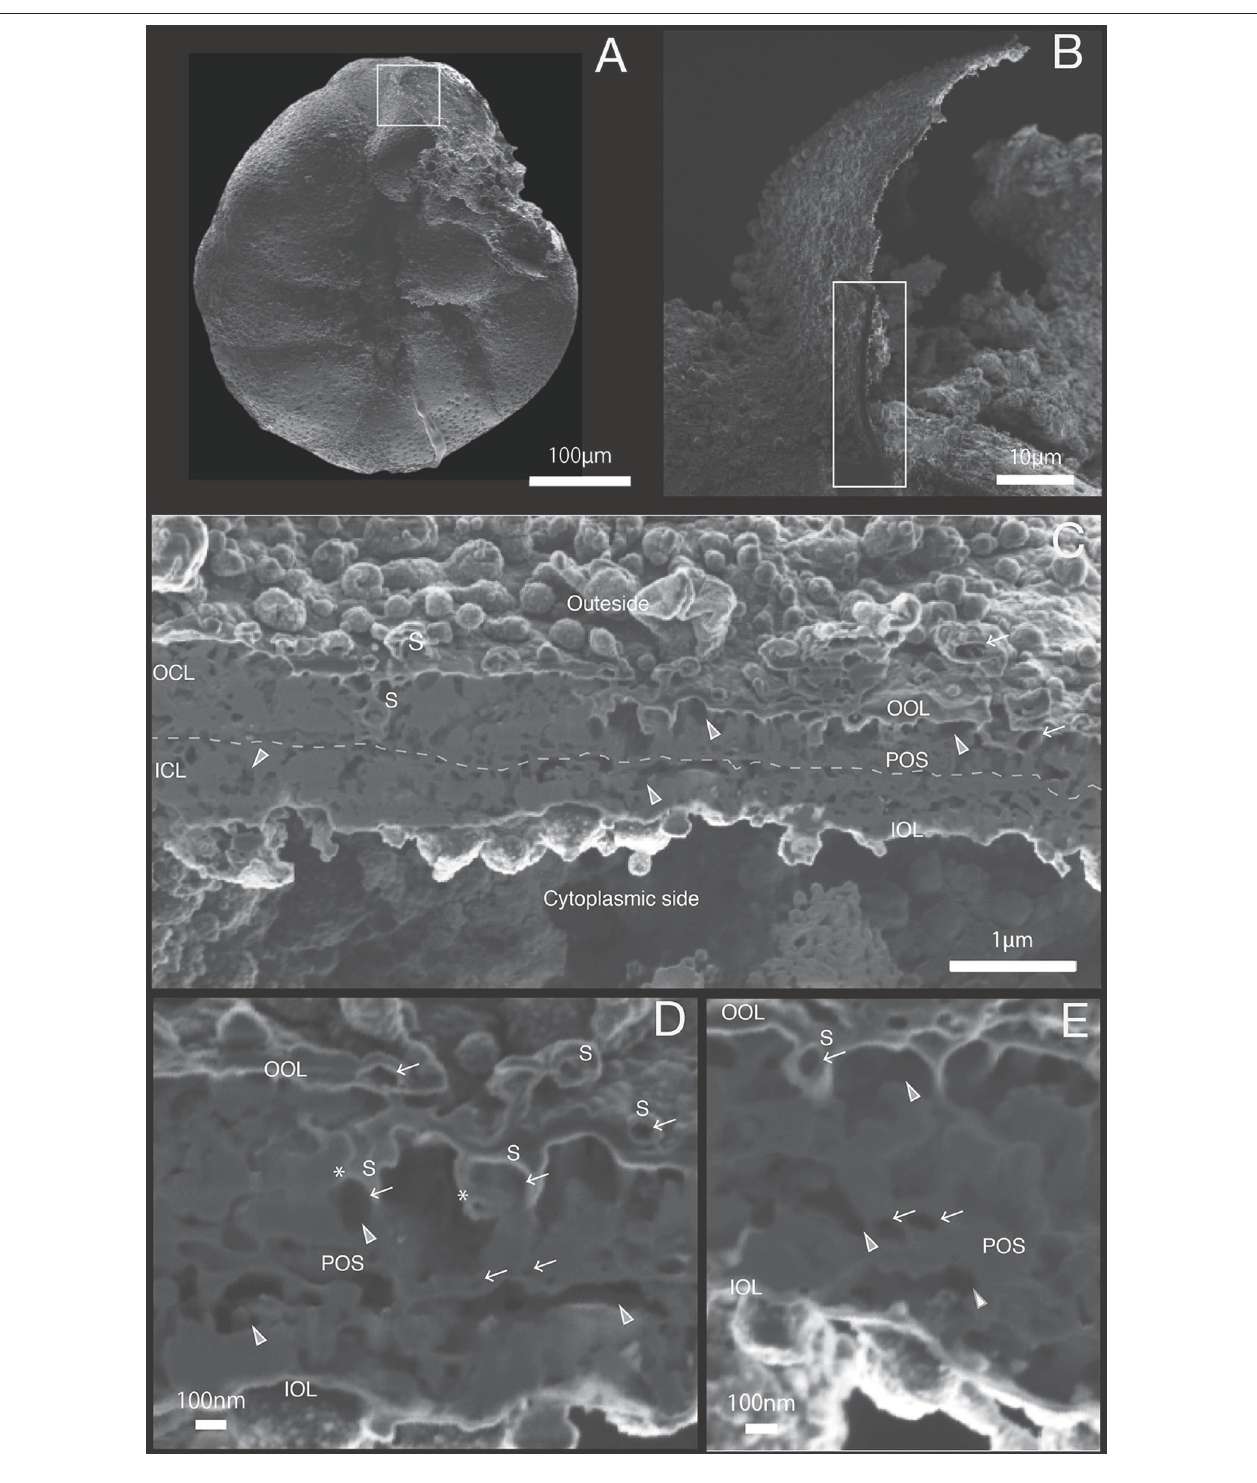
FIGURE 4 | SEM images of specimen #3. (A) Overview. (B) The newly calcified chamber (white rectangle in (A) . The field of FIB processing is indicated by the white rectangle. (C) Composite SEM image of the FIB processed SOC. Upper side is the outer side and whereas the lower side is the cytoplasmic side. White dotted line in the calcareous layer indicates the boundary between outer side and cytoplasmic side of calcareous layer. (D) Magnified image of porous structure of SOC. (E) Higher magnification showing the cavities within primary organic sheet and outer organic layer. OOL, outer organic layer; OCL, outer calcareous layer; POS, primary organic sheet; ICL, inner calcareous layer; IOL, inner organic layer; S, spherical structures; CM, calcareous materials; gray triangle, void; white arrow, cavity; asterisk, opening spherical structure from cavity into void.